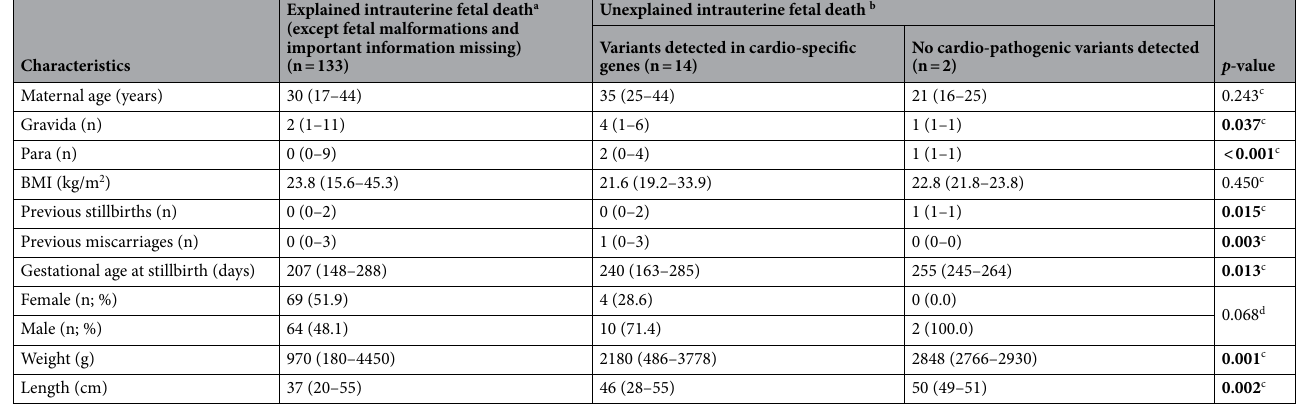
Table 2. Maternal and fetal characteristics compared between explained and unexplained causes of fetal death. BMI body mass index, cm centimeter, g gram. a Causes of fetal death: placental dysfunction, cord complications, infection, “others”: e.g. fetal hydrops of unknown origin; maternal disease; fetal/maternal trauma. Excluded: congenital malformations (n = 32) and unknown because important information missing (n = 26). b Study subjects of “unknown cause of fetal death despite thorough investigation” which underwent targeted sequencing. c Mann–Whitney U test comparing non-parametric continuous data (median;